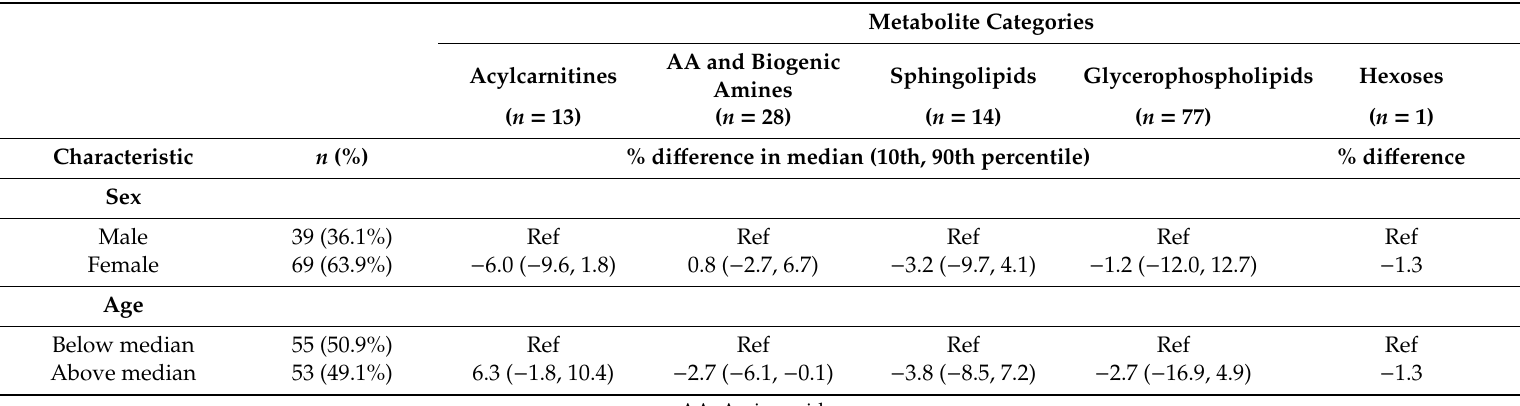
Table 2. Median (10th percentile, 90th percentile) percentage di ff erences in mean metabolite concentrations by age and sex within metabolite class in the PRÄVENT cohort ( n = 108).